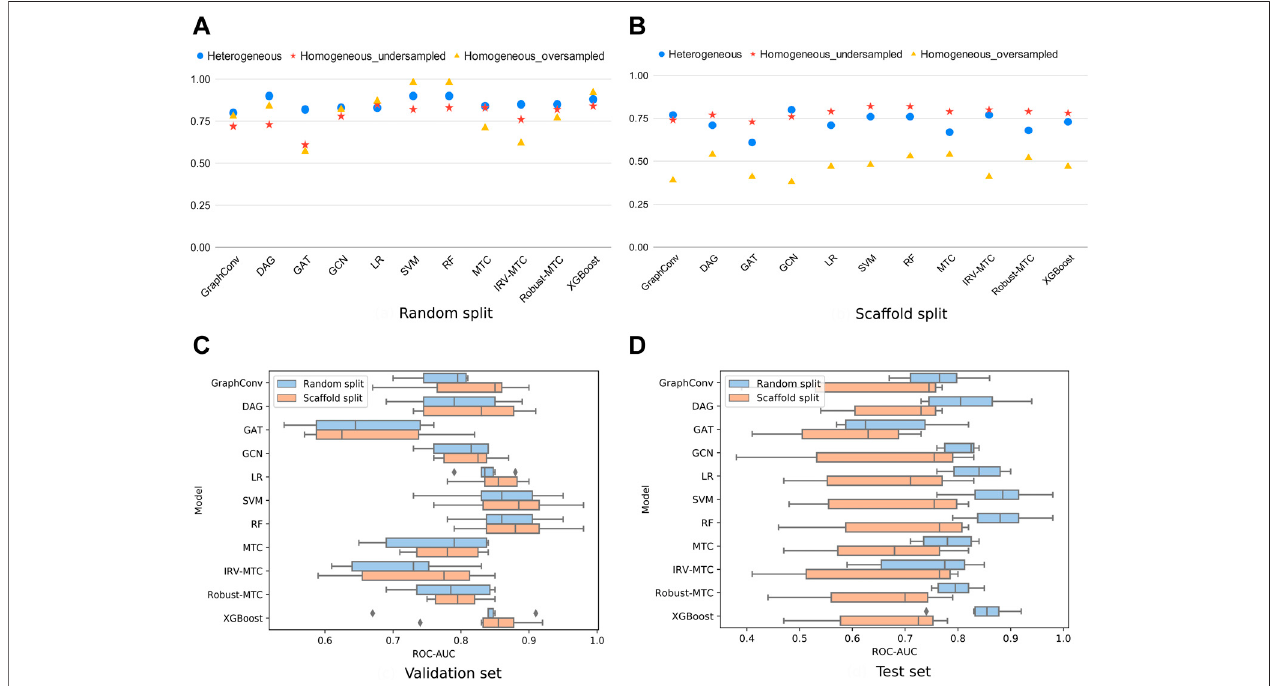
FIGURE2| ROC-AUCscoresofallmodelsforthreedifferentdatasets(heterogeneous,undersampledhomogeneous,andoversampledhomogeneous). (A) ROC- AUCscoresachievedbyallmodelsundertherandom80/10/10split. (B) ROC-AUCscoresachievedbyallmodelsunderthescaffold80/10/10split. (C) Boxplots ofthe ROC-AUC scores achieved byeach model onall validationsubsets (heterogeneous,undersampled homogeneous, and oversampledhomogeneous included) and with both splitting proportions (80/10/10; 60/20/20). (D) Boxplots of the ROC-AUC scores achieved by each model on all test subsets (heterogeneous, undersampled homogeneous, and oversampled homogeneous included) and with both splitting proportions (80/10/10; 60/20/20).